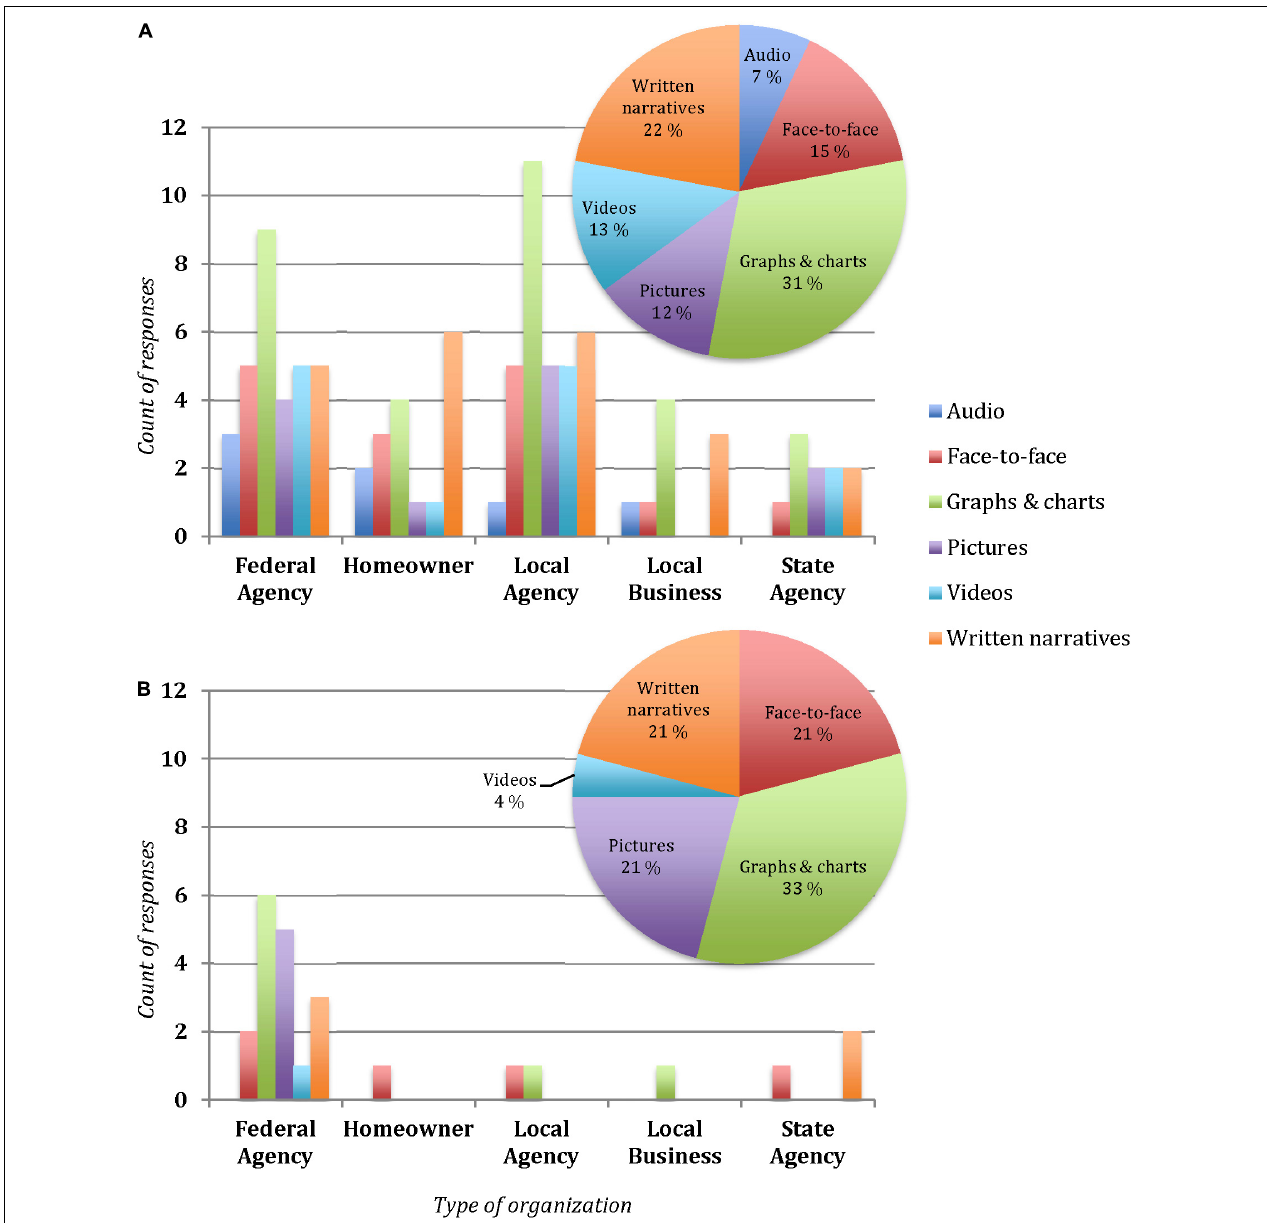
FIGURE 3 | Preferred formats to receive GLOF information by type of organization for (A) Juneau interviewees ( n = 35) and (B) Kenai Peninsula interviewees ( n = 13). Interviewees could list multiple preferred formats, thus number of responses exceed number of interviewees. The pie chart is an aggregated representation of all interviewee responses in each case,